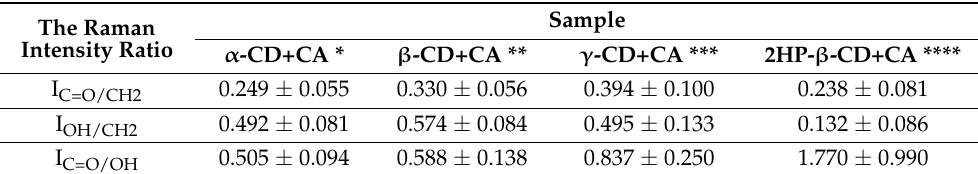
Table 3. The comparison of Raman intensity ratios for specific chemical groups. The calculated results are demonstrated as mean ± standard deviation (SD).